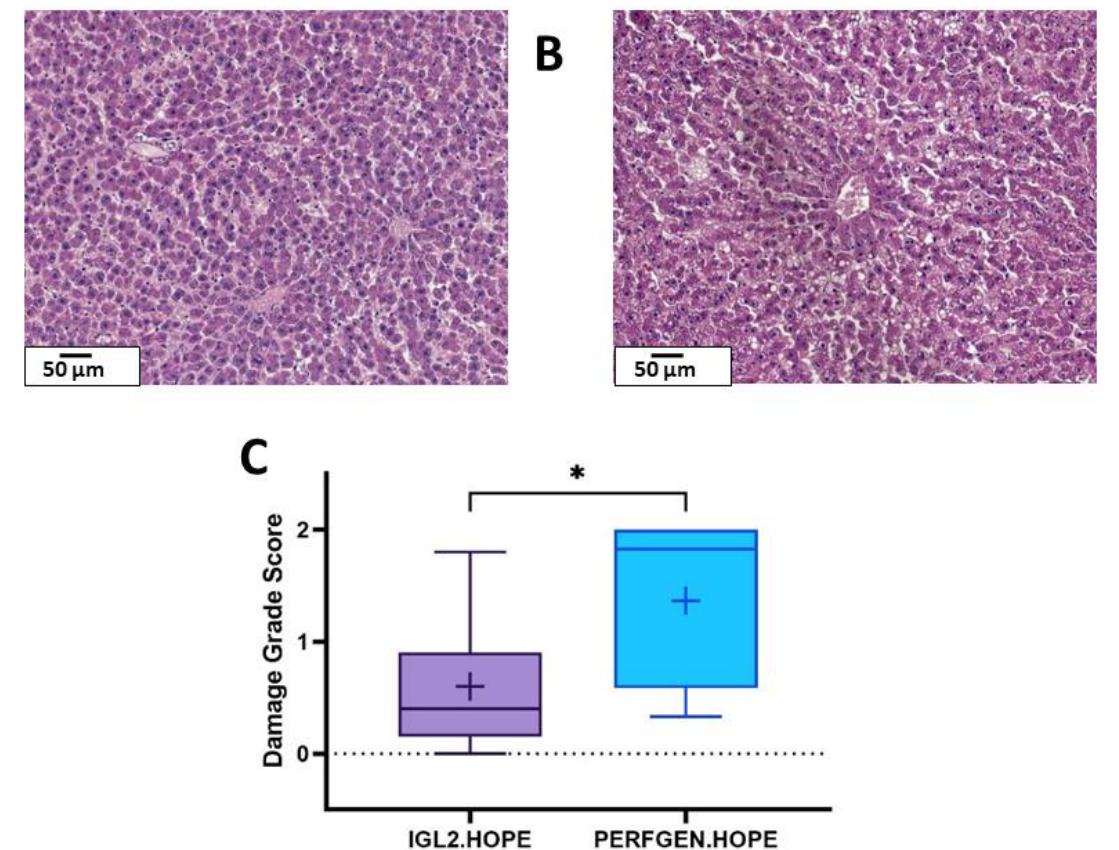
Figure 5. Liver histology after 24 h SCS + 2H HOPE + 2H NMP. ( A ) IGL2.HOPE ( B ) PERFGEN.HOPE ( C ) The damage grade score (DGS) was assessed by an expert pathologist and was significantly lower for the IGL2 group ( p = 0.02). (Kruskal–Wallis test). * = p < 0.05.